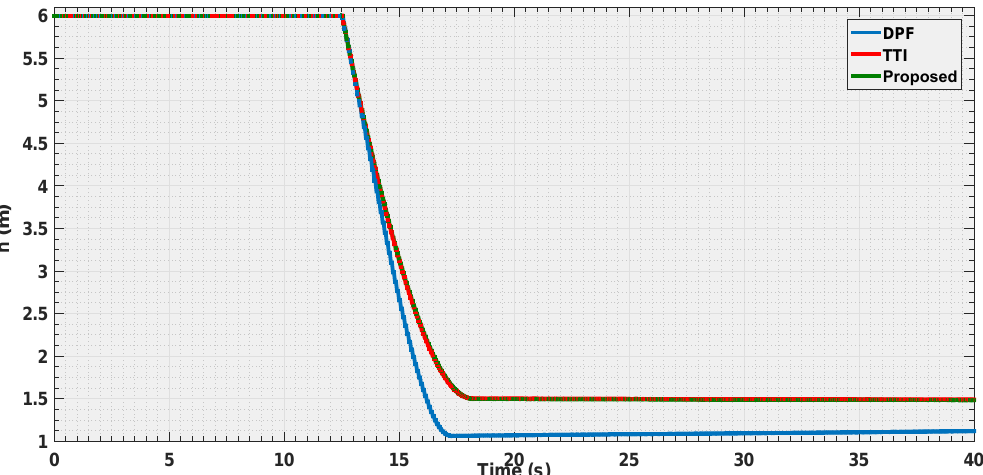
Figure 15. Distance estimation by the three evaluated algorithms Experiment 2 .